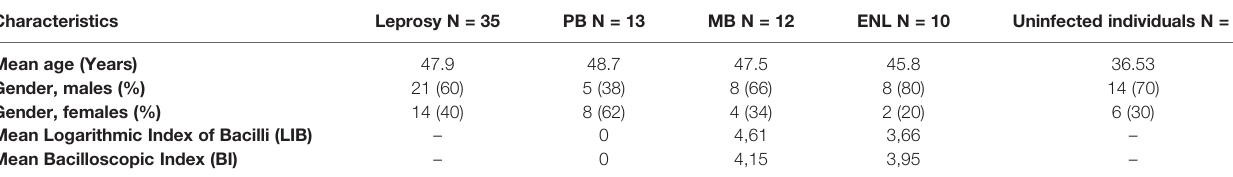
TABLE 1 | Baseline characteristics of patients and uninfected individuals whose B cells were analyzed by fl ow cytometry.